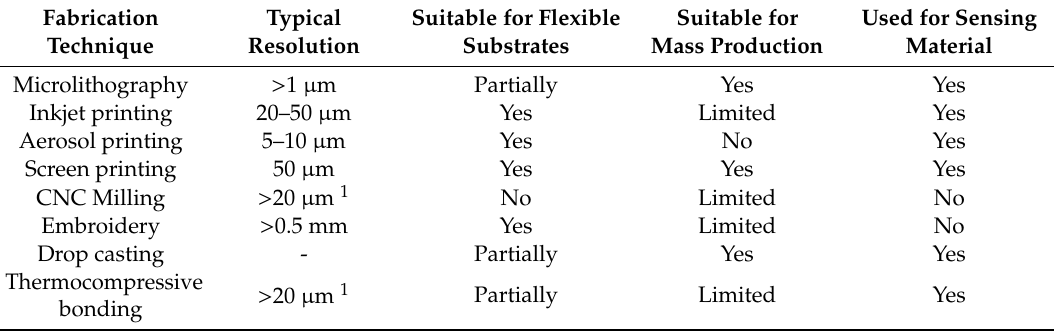
Table 2. Comparison of di ff erent techniques used for the fabrication of chipless